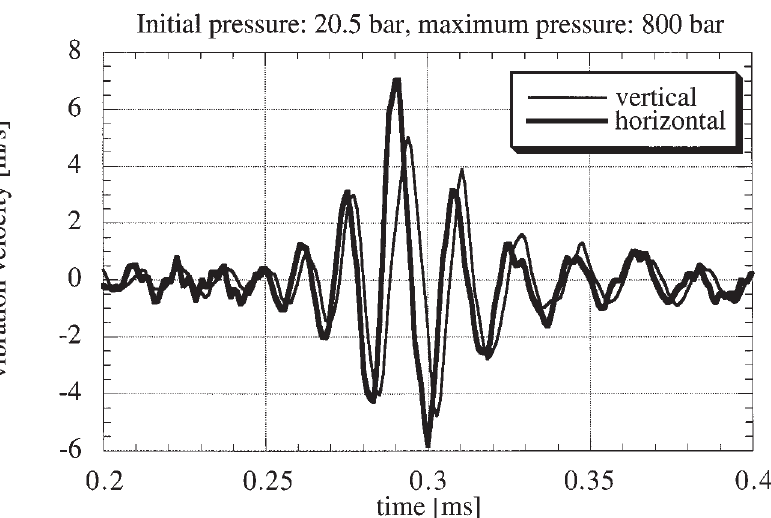
Fig. 7. Time series of radial vibration velocity.